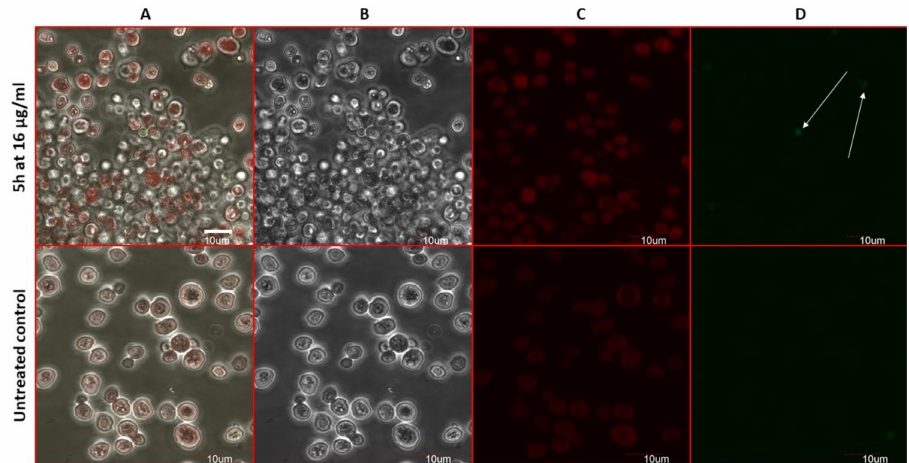
Figure 10. The C. neoformans SPZ173 biofilm-death assessment. Legend: Confocal laser scanning microscope (CLSM) analyses of acridine orange (AO)- and ethidium bromide (EB)-stained biofilm cells. ( A ) phase contrast and fluorescence merged; ( B ) phase contrast and ( C ) fluorescence images. ( A – C ) Upper raw shows alive cells treated with 5h at 16 µ g/mL. ( D ) Viable cells appear green with intact nuclei (arrows). Lower raw displays viable untreated control